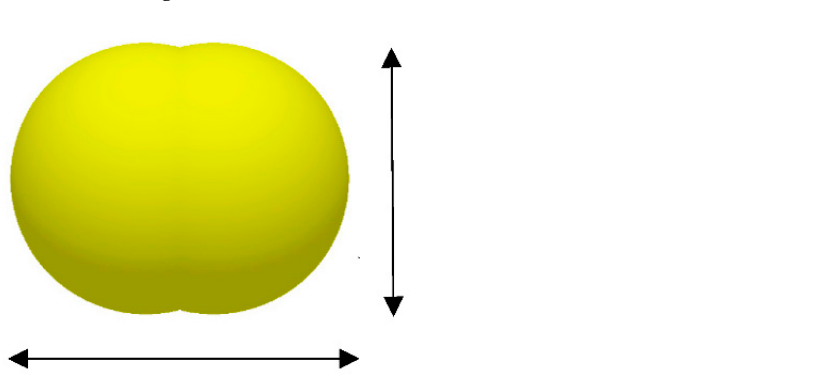
Figure 1. Bi-sphered particle with an aspect ratio of 1.25 used in the DEM simulations.